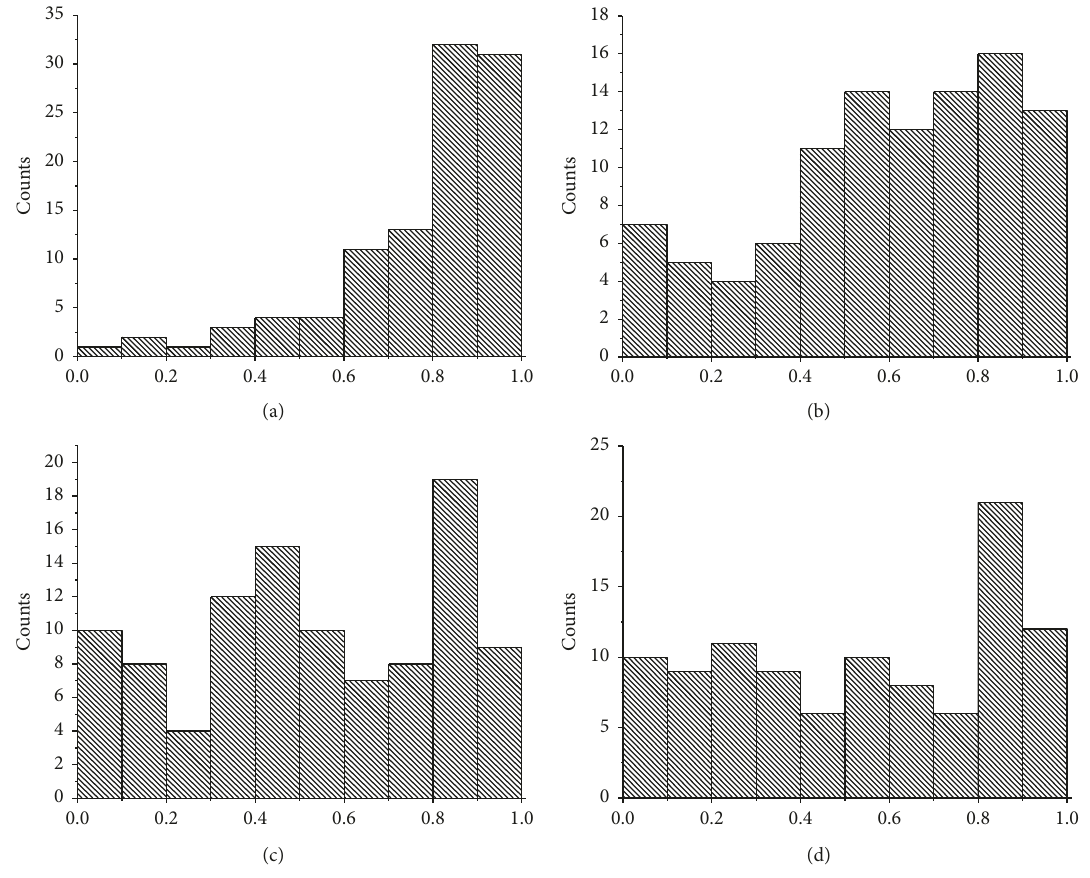
Figure 8: Distribution rule of each coefficient of simulation scenarios: (a) D